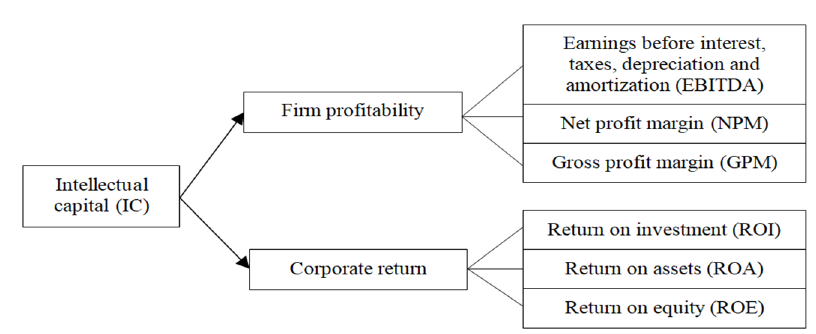
Figure 1. Conceptual